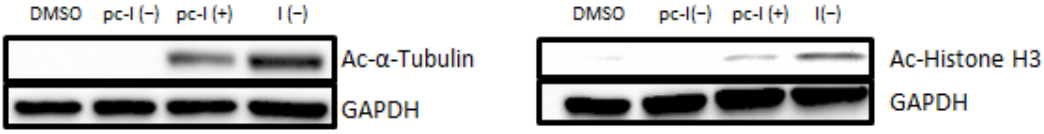
Figure 4. Representative immunoblot analysis of acetylated α -tubulin and histone H3. MV-3 cells were incubated for 24 h with I and pc-I at a concentration of 3.1 µM. Afterward, cell lysates were immunoblotted with an anti-acetyl- α -tubulin and anti-acetyl-histone H3 antibody. GAPDH was used as loading control. (+): UV irradiation at 365 nm for 10 min. ( − ): no treatment with UV light.